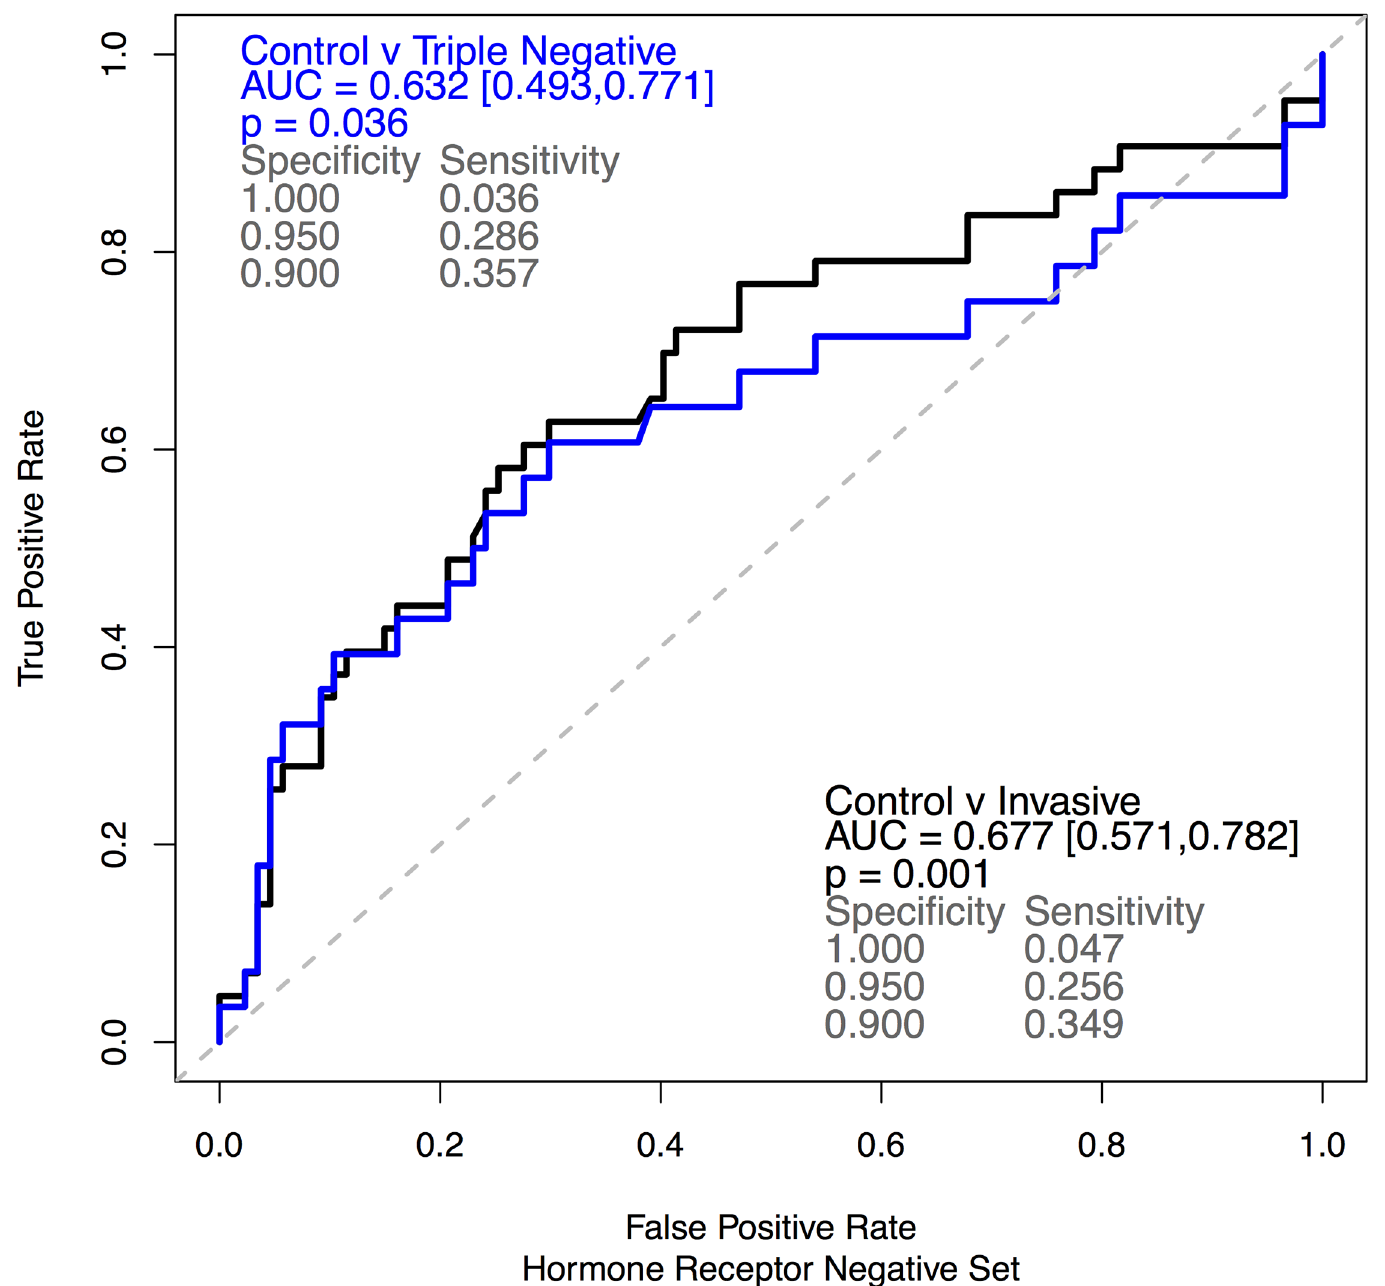
Fig 1. Autoantibodies to TP53 discriminate breast cancer sera from control sera. ROC curves showing the 43 HRN cases (black) and the 28 TN subset (blue) vs. 87 matched healthy controls.